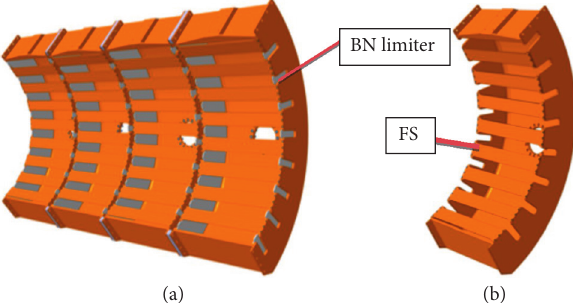
Figure 2: Integration of FS by four modules (a) and one module of FS